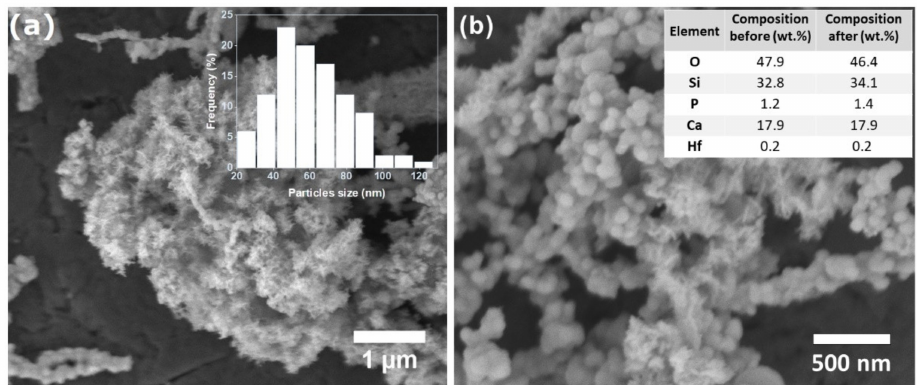
Figure 2. Representative SEM images of BGl@PcHfCl 2 . Insets show histogram of size particle distribution ( a ) and initial and final (based on EDX analysis) glass composition ( b ).